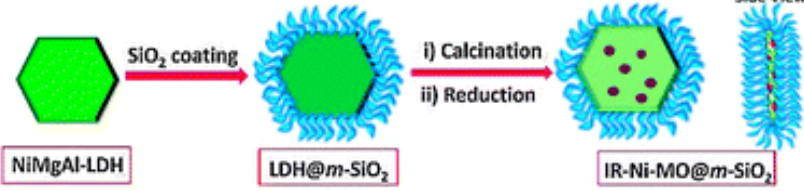
Figure 13. Schematic illustration of the modular catalysts. Reproduced with permission from reference [189].